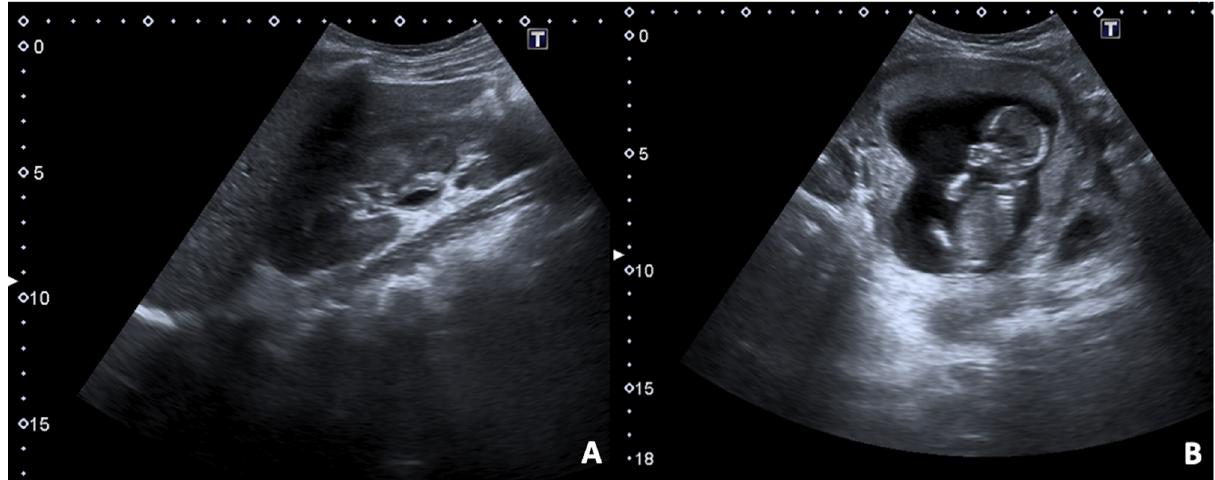
Figure 10. US B-mode scans in a pregnant woman arrived in the ER presenting fever and dysuria associated with right flank and pelvic pain. ( A ) A longitudinal image of hepato-renal scan shows thickened wall of right renal pelvis due to inflammation; ( B ) in the pelvis the foetus within the gravid uterus is demonstrated.